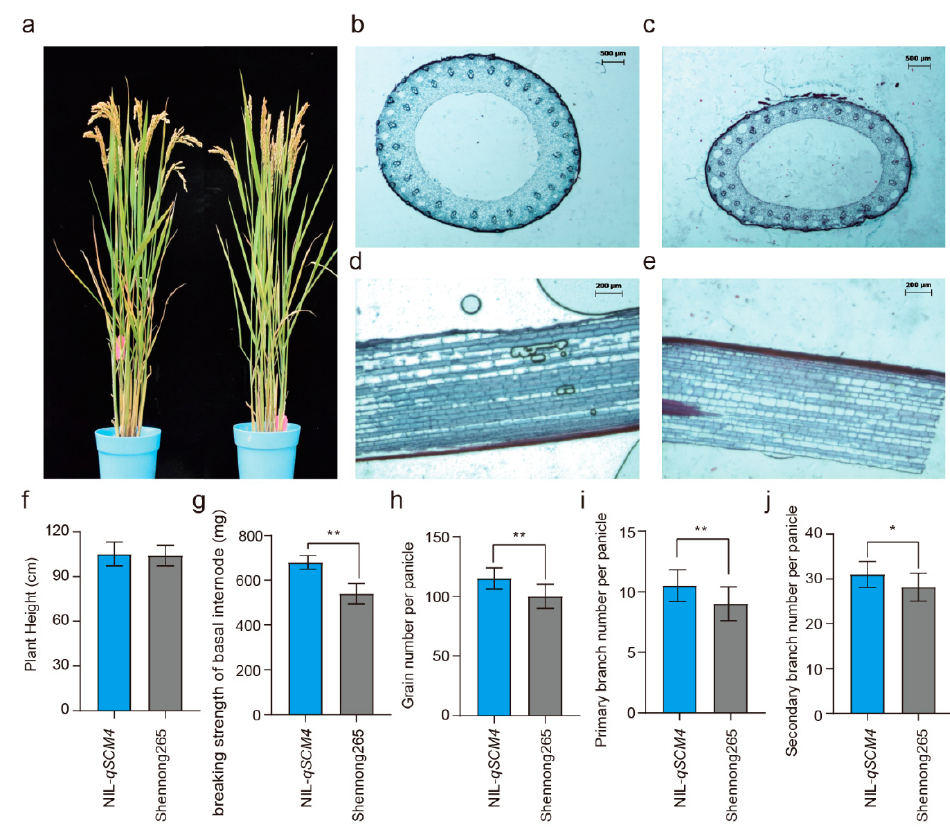
Figure 3. Analysis of yield and lodging-related traits in the near-isogenic lines with strong culm resistance QTL- qSCM4 : ( a ) comparison of plant size of NILs; ( b ) cross section of the basal internode of NIL- qSCM4 ; ( c ) cross section of the basal internode stem of SN265; ( d ) the basal internode wall of NIL- qSCM4 ; ( e ) the basal internode stem wall of SN265; ( f ) comparison of plant height between two NILs; ( g ) comparison of breaking strength between two NILs; ( h ) comparison of grain number per panicle between two NILs; ( i ) comparison of the number of primary branch between two NILs; and ( j ) comparison of the number of secondary branch between two NILs. * p < 0.05, ** p < 0.01, using Student’s t -test.